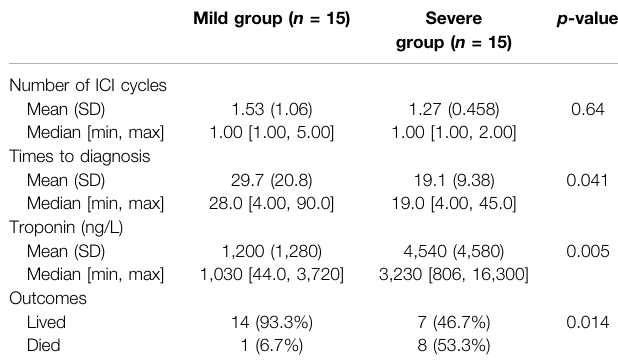
TABLE 6 | Patients with immune-related myocarditis searched in PubMed were